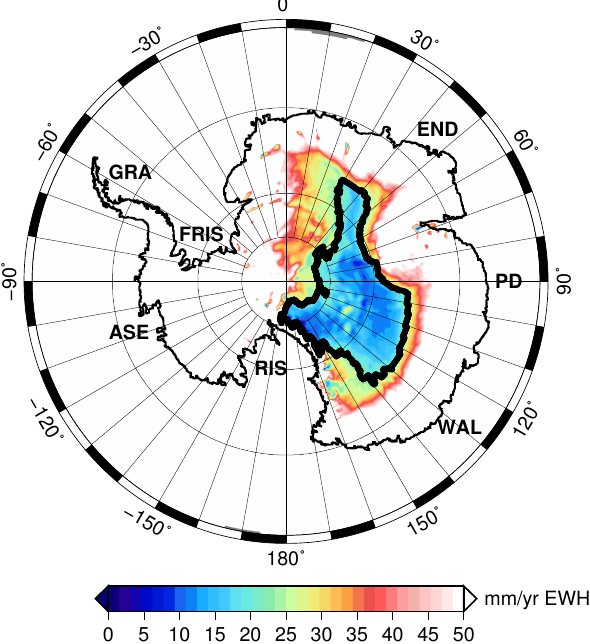
Fig. 4. Outline of the low-precipitation zone (LPZ; black line) over- laid onto estimates of average yearly solid precipitative flux in units mm EWH · yr − 1 , together with the following location indica- tors: Amundsen Sea (ASE), Graham Land (GRA), Filchner Ronne Ice shelf (FRIS), Enderby Land (END), Philippi/Denman (PD), Wilkes/Adelie Land (WAL), Ross Ice shelf (RIS).